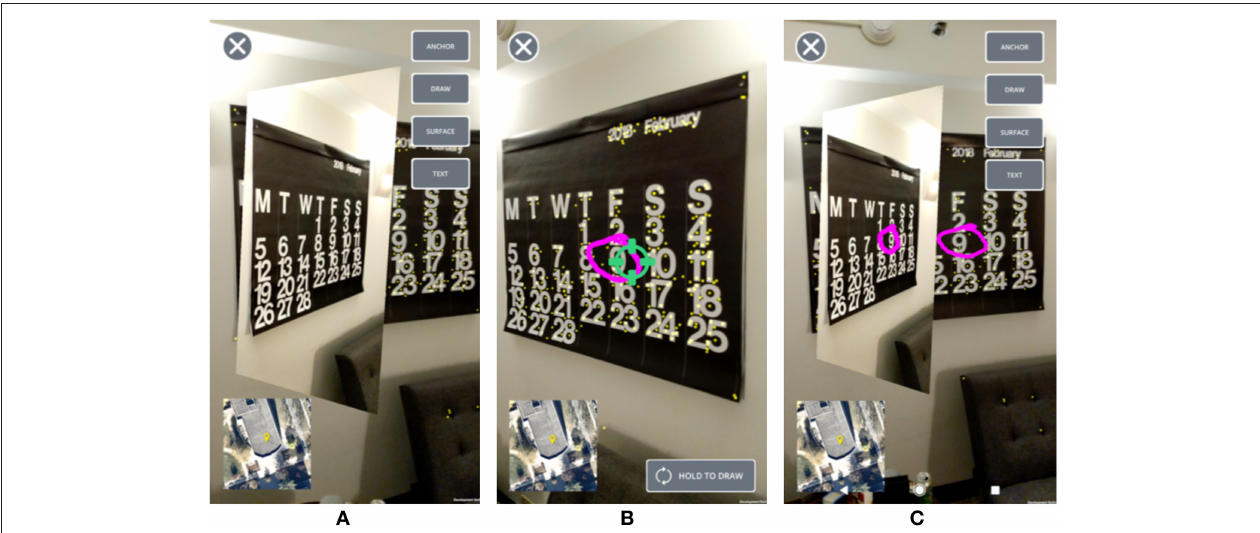
FIGURE 8 | (A) Image projected into the scene, yellow dots represent the point cloud. (B) Surface tool being used to annotate on the point cloud. (C) Illustration of projection onto the image for off site viewing.